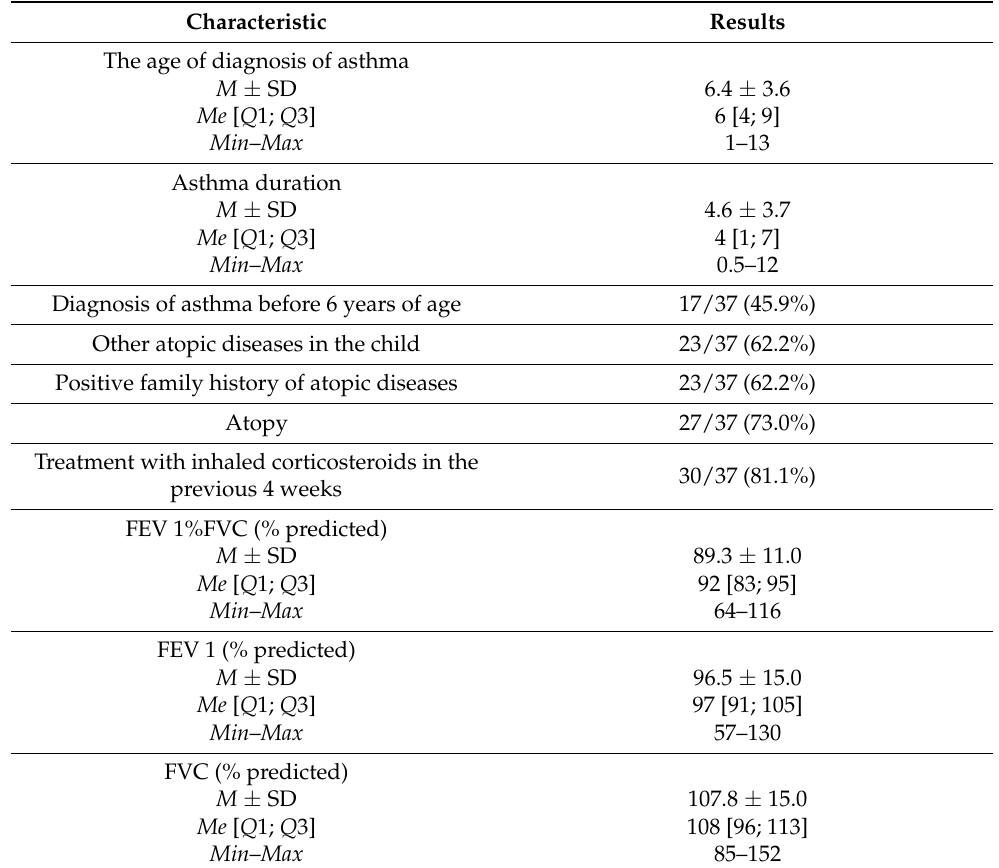
Table 2. Asthma and allergy status characteristics ( n = 37).